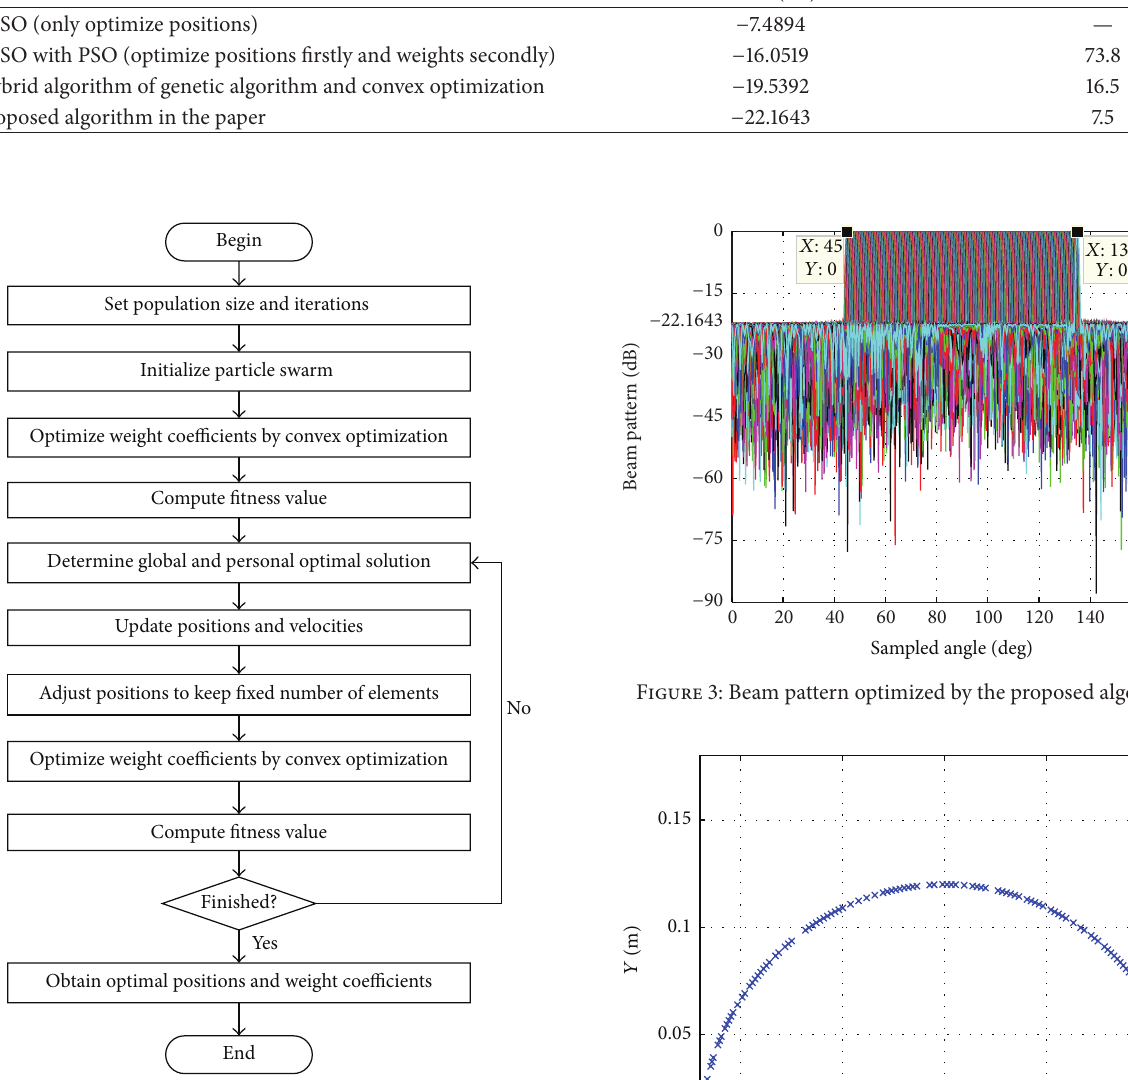
Figure 2: Procedure of the proposed algorithm.